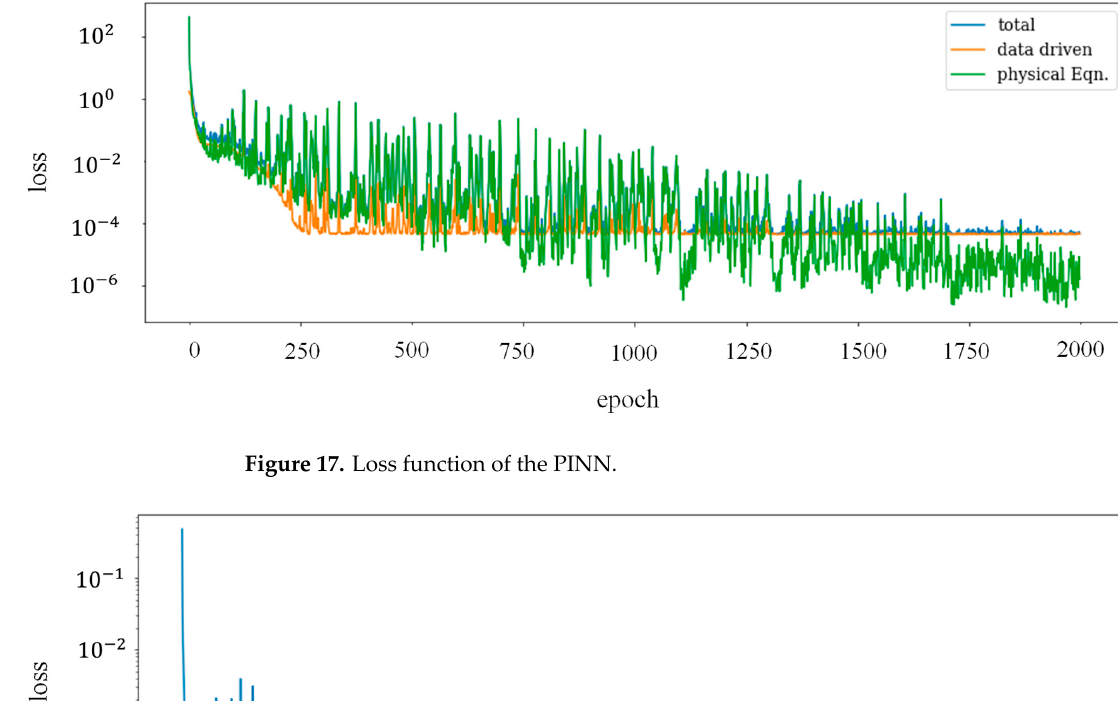
Figure 16. Physic equation satisfaction of the PINN during two natural training periods: ( a ) input data consistency; ( b ) physics equation satisfaction 0*.